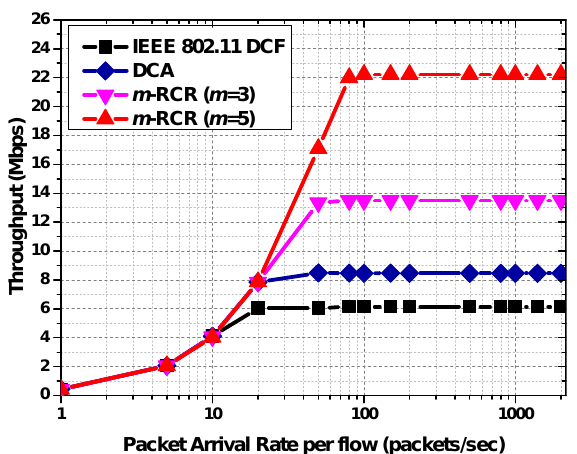
Fig. 5. Average packet delay versus number of data